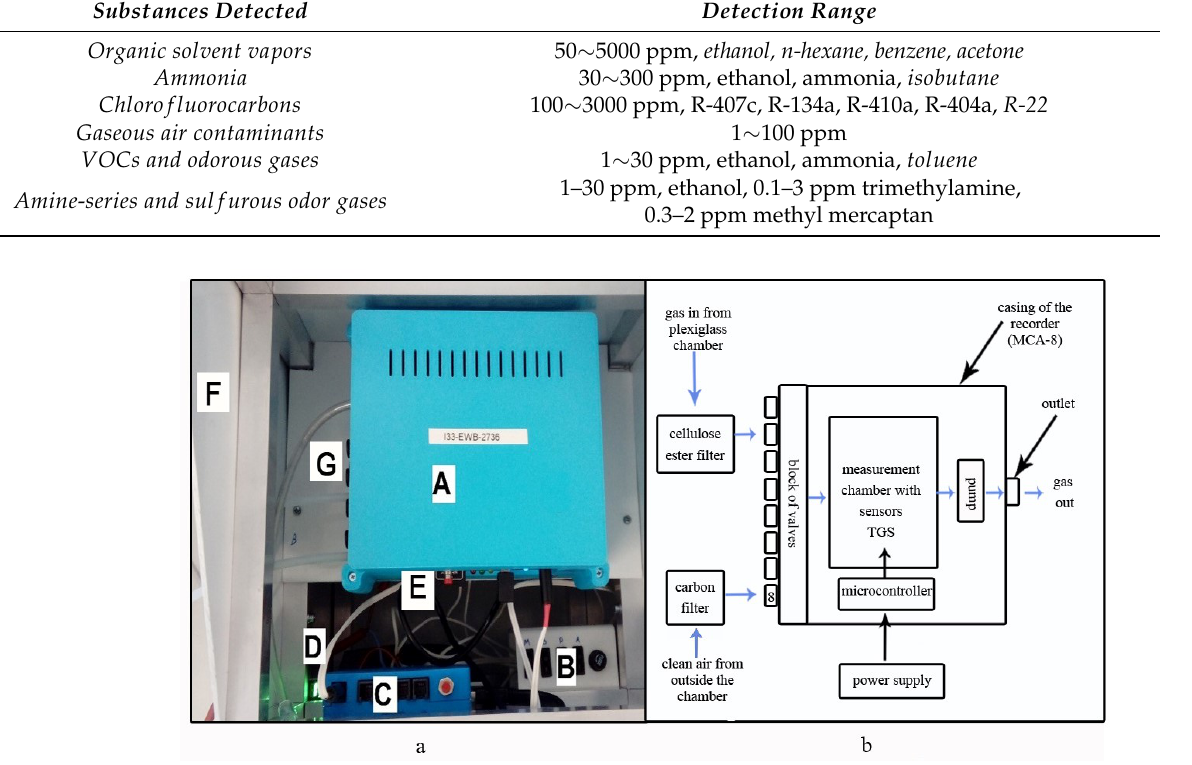
Figure 1. MCA-8 measurement device: ( a ) general view: A, multi-sensor recorder (MCA-8); B, power supply control panel; C, control panel for data transfer to the server; D, power cord; E, card reader; F, housing; and G, inlet channels; and ( b ) block diagram with marked construction elements and directional gas 80